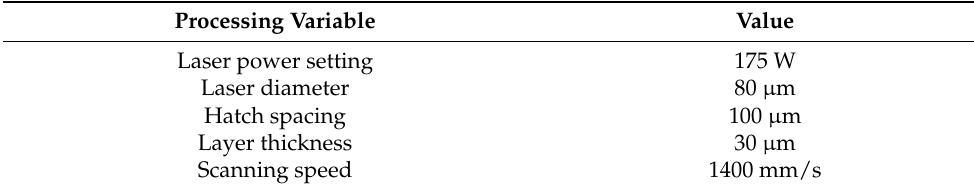
Table 2. EOSINT M280 DMLS processing